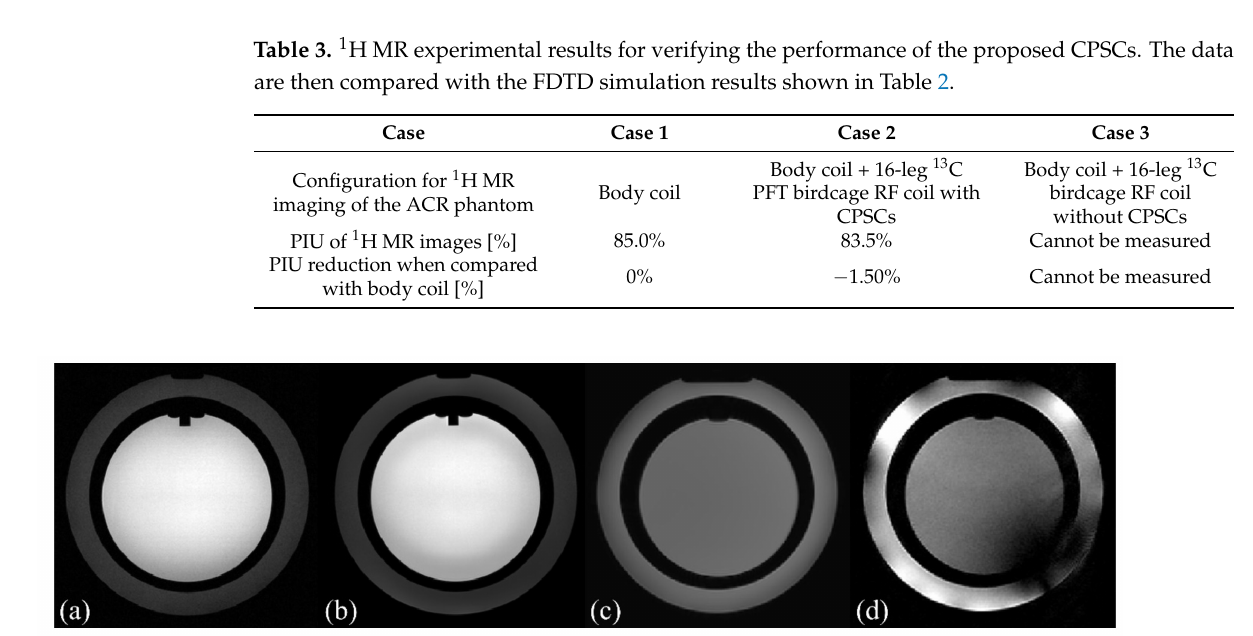
mapping FDTD simulation from the body coil to verify the performance of the 1